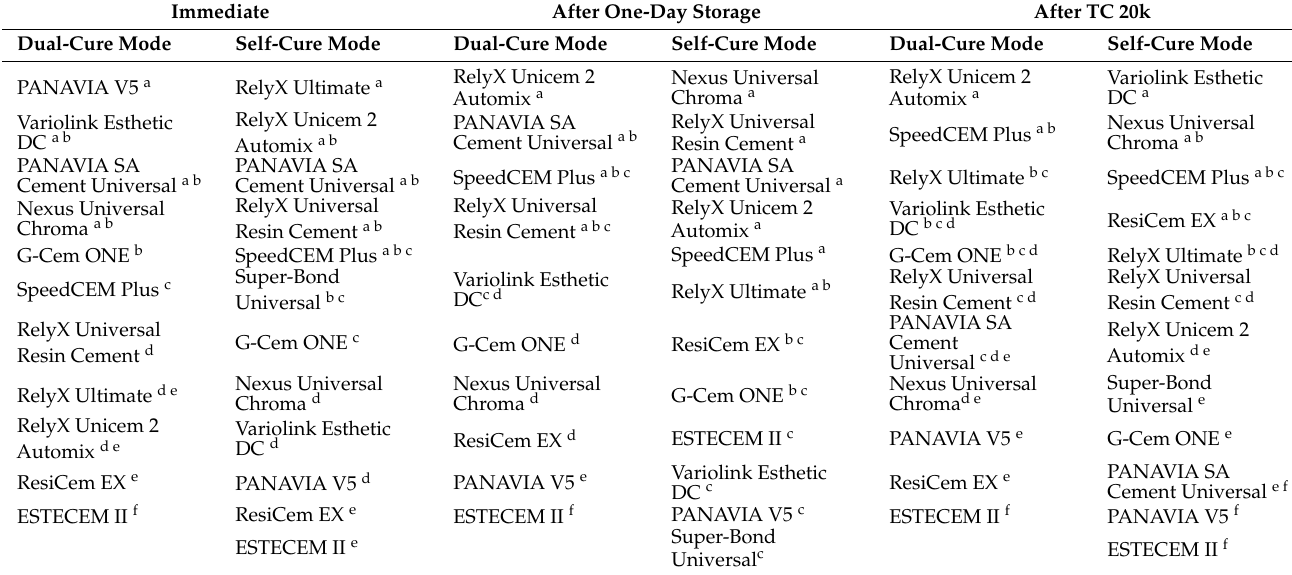
Table 9. Comparison of means (Tukey HSD procedure) for flexural strength of resin cement material at each time [superscript letters (a–f) represent groups with no significant difference, p > 0.05].